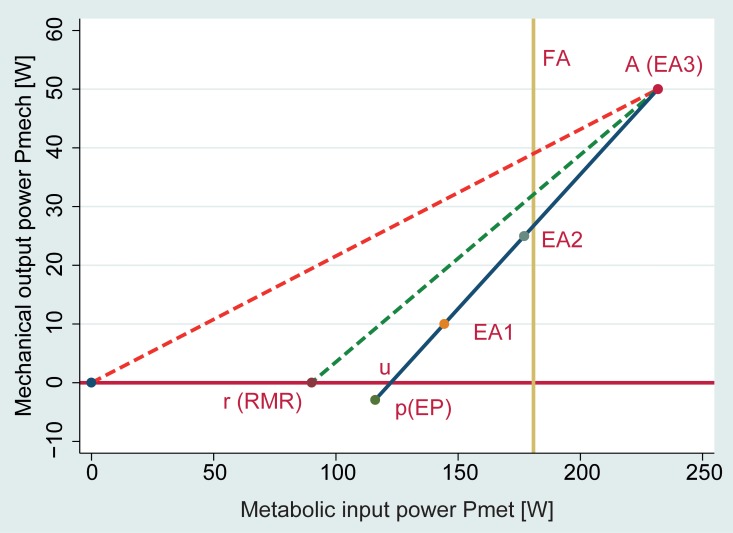
Hunt’s diagram [2,22] outlining the efficacy of volitional exercise relative to metabolic cost of unloaded FES cycling (yellow line).Note: Metabolic efficiency is the gradient of the line joining the active cycling operating point (A) to one of the baseline conditions: u is unloaded cycling; r is rest, p is passive cycling.